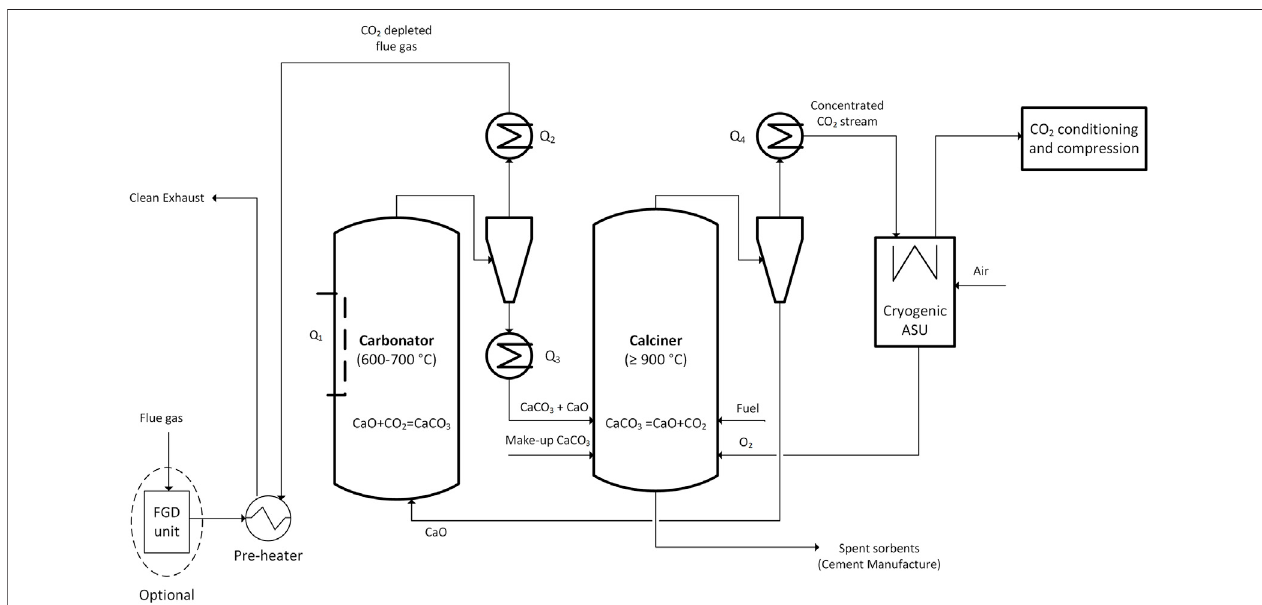
FIGURE 8 | Schematic presentation of the calcium looping process for post-combustion CO 2 capture. Adapted from Zhao et al. (2013). Note: FGD, Flue Gas Desulphurization; and ASU, Air Separation Unit. Possibilities for heat recovery include heat that can be released from i) exothermic carbonation reaction (Q 1 ), which is higherthanwhatisrequiredtomaintaintheCFBcarbonator ’ stemperature;ii)andiii)hotCO 2 -depleted fl uegas(Q 2 )andhotCaO/CaCO 3 streams(Q 3 )leavingcarbonator cyclone at a temperature > 600 ° C; and fi nally iv) very hot CO 2 rich gas ( > 800 ° C) leaving oxy-fuel CFB calciner ’ s cyclone (Q 4 ). Q 2 and Q 4 can generate steam cycles for extra electricity